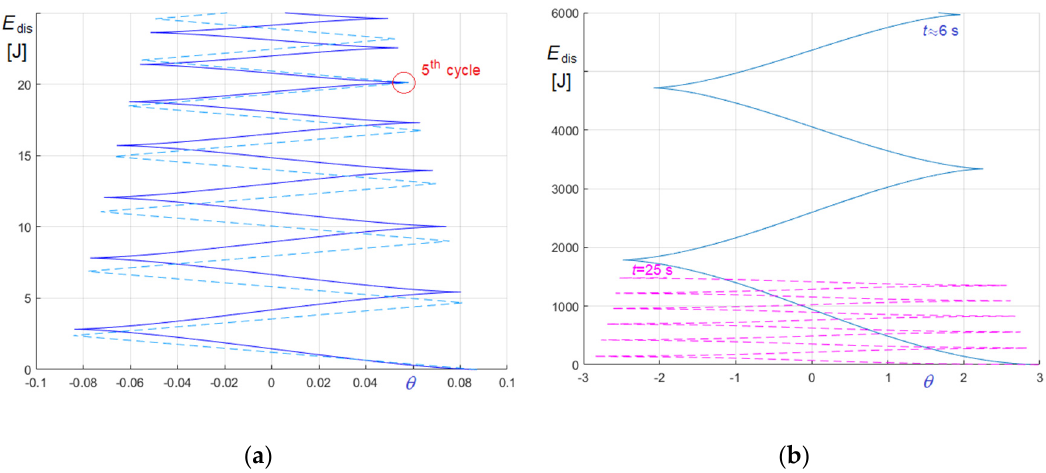
Figure 20. Comparison of energy dissipation caused by friction (dashed lines) and by “5 ◦ equivalent” viscosity (solid lines): ( a ) θ 0 = 5 ◦ damped oscillations; ( b ) case I.a − θ 0 = 171 ◦ damped oscillations.